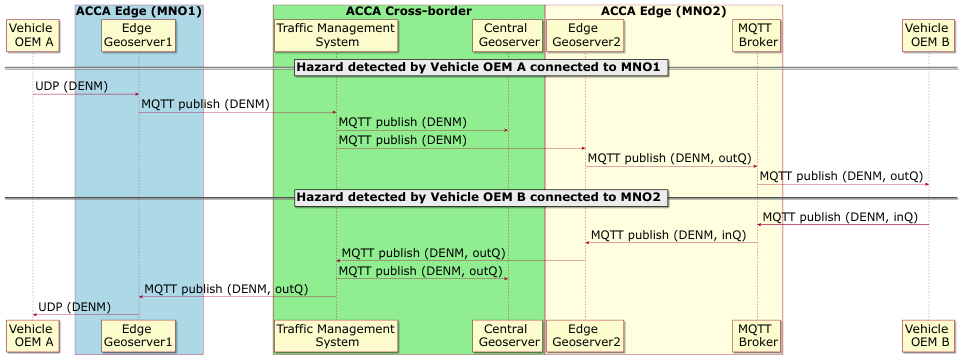
Figure 3. End-to-end propagation of detected hazardous events via Distributed Environmental Notification Message (DENMs) from/to the OBUs from two different vehicle